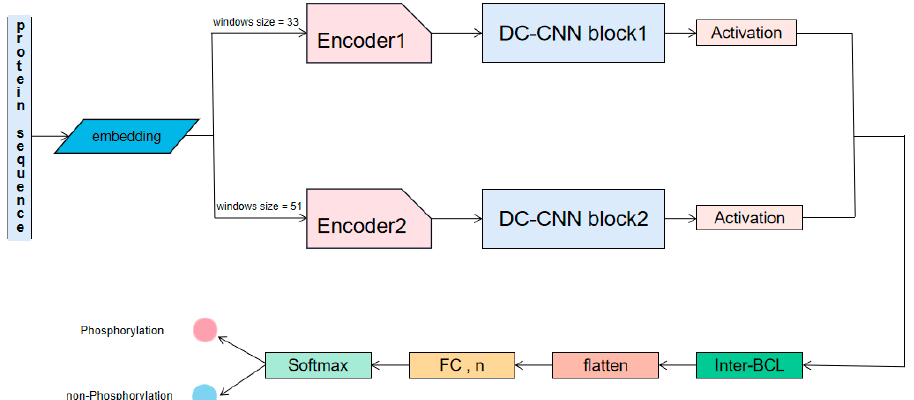
Figure 3. The overall framework of TransPhos. The original sequence is converted into a set of feature vectors with different window sizes through an embedding layer. Here, we set 2 different window sizes: 51 and 33. The sequence features are further represented by the encoder, and then the high-dimensional features are extracted through several densely connected convolutional neural networks (DC-CNN) blocks. After the activation function, the representations obtained by several DC-CNN blocks are concatenated by intra-block connectivity layer (Inter-BCL) and converted to a one-dimensional tensor by a flatten layer. After a full connection (FC) layer, the phosphorylation prediction is finally generated by the SoftMax function.